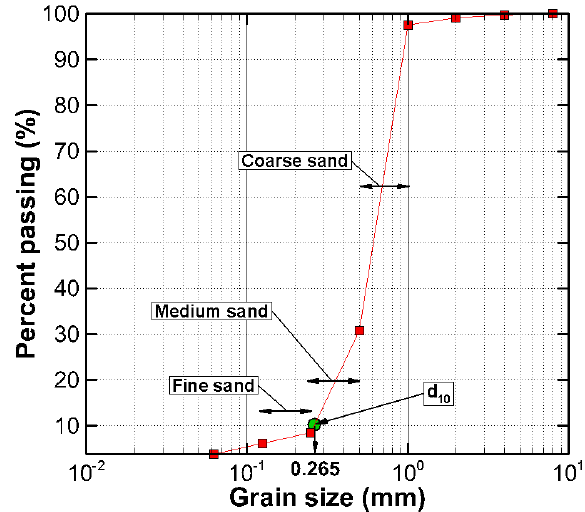
Figure 1. Particle grading curve of sandy soil samples.